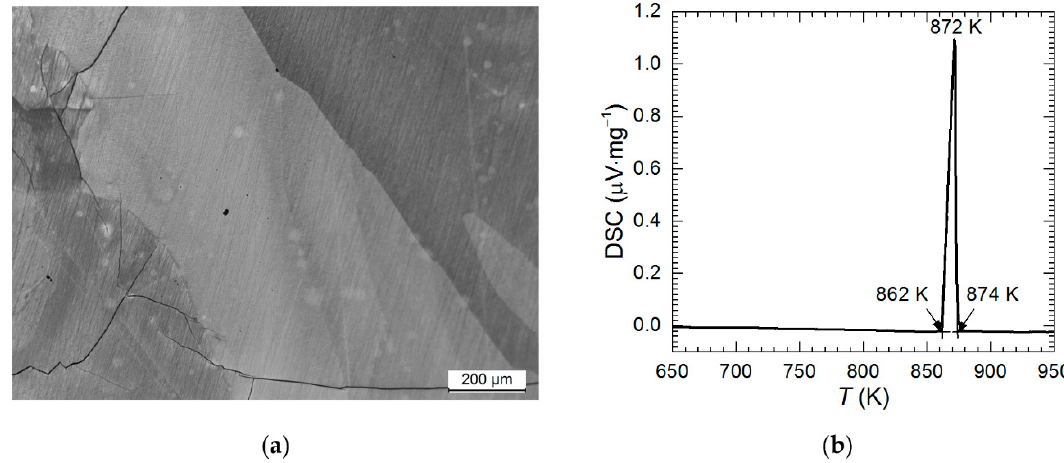
Figure 2. Characterization of phase composition of Al 2 Cu intermetallic phase: ( a ) photomicrograph of the specimen etched using Keller’s reagent; ( b ) DSC curve obtained for heating rate 5 K·min − 1 in He atmosphere.